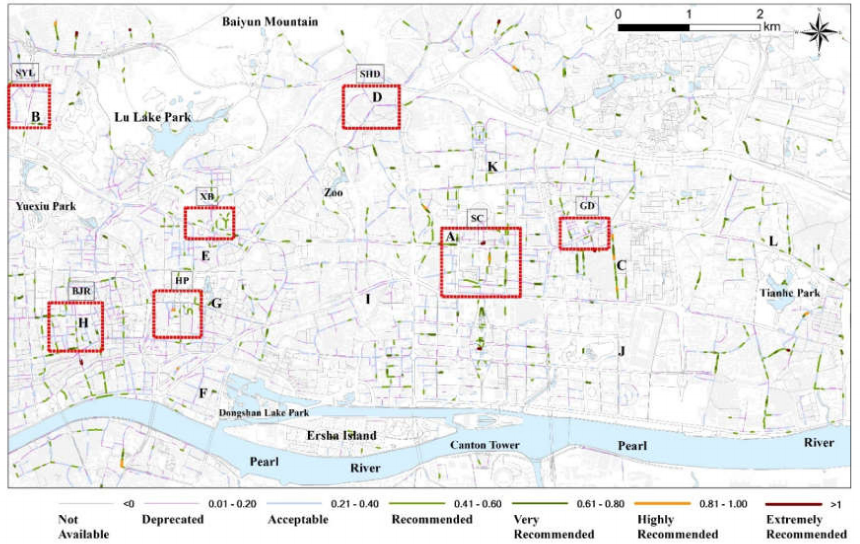
Figure 6. Results of the dining walking index (DWI). SYL: Sanyuanli Business District; SHD: Shaheding Business District; XB: Xiaobei Business District; BJR: Beijing Road Business District; HP: Hero Plaza Business District; SC: Sport Center Business District; GD: Gangding Business